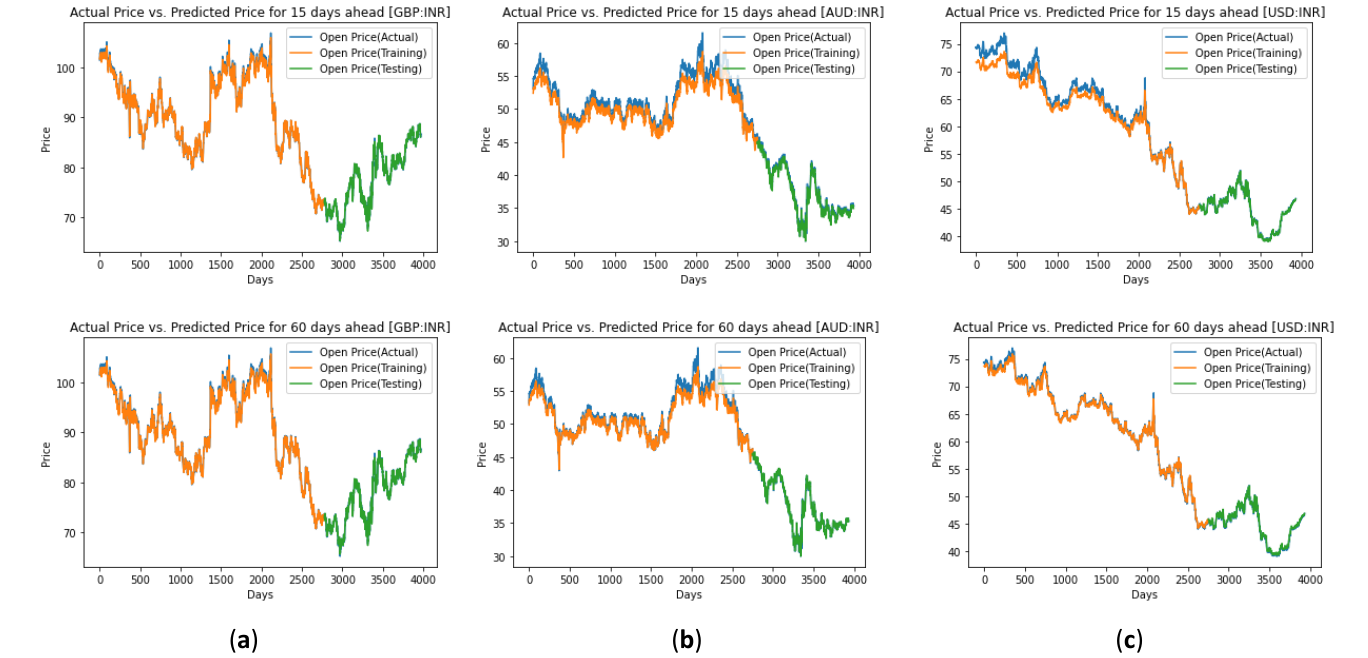
Figure 6. Short-term and long-term prediction graphs and MSE graphs using CNN-LSTM for ( a )